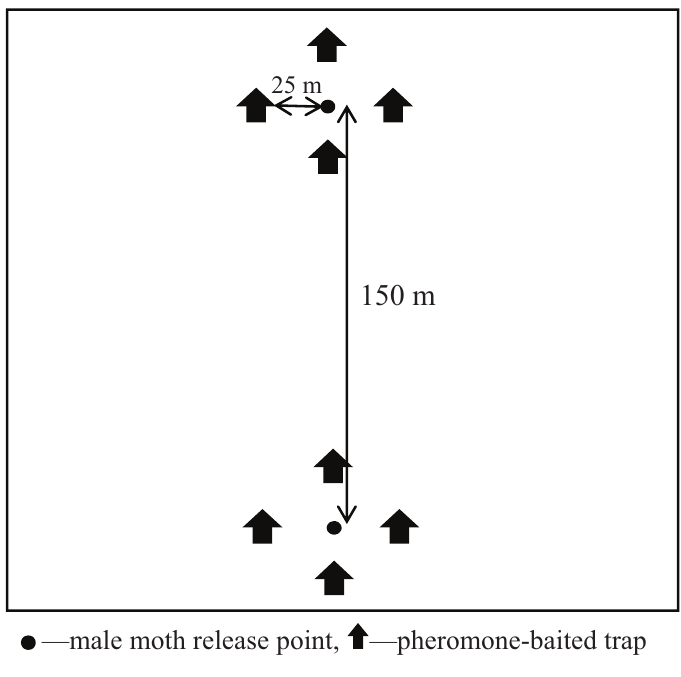
Figure 1. Experimental plot